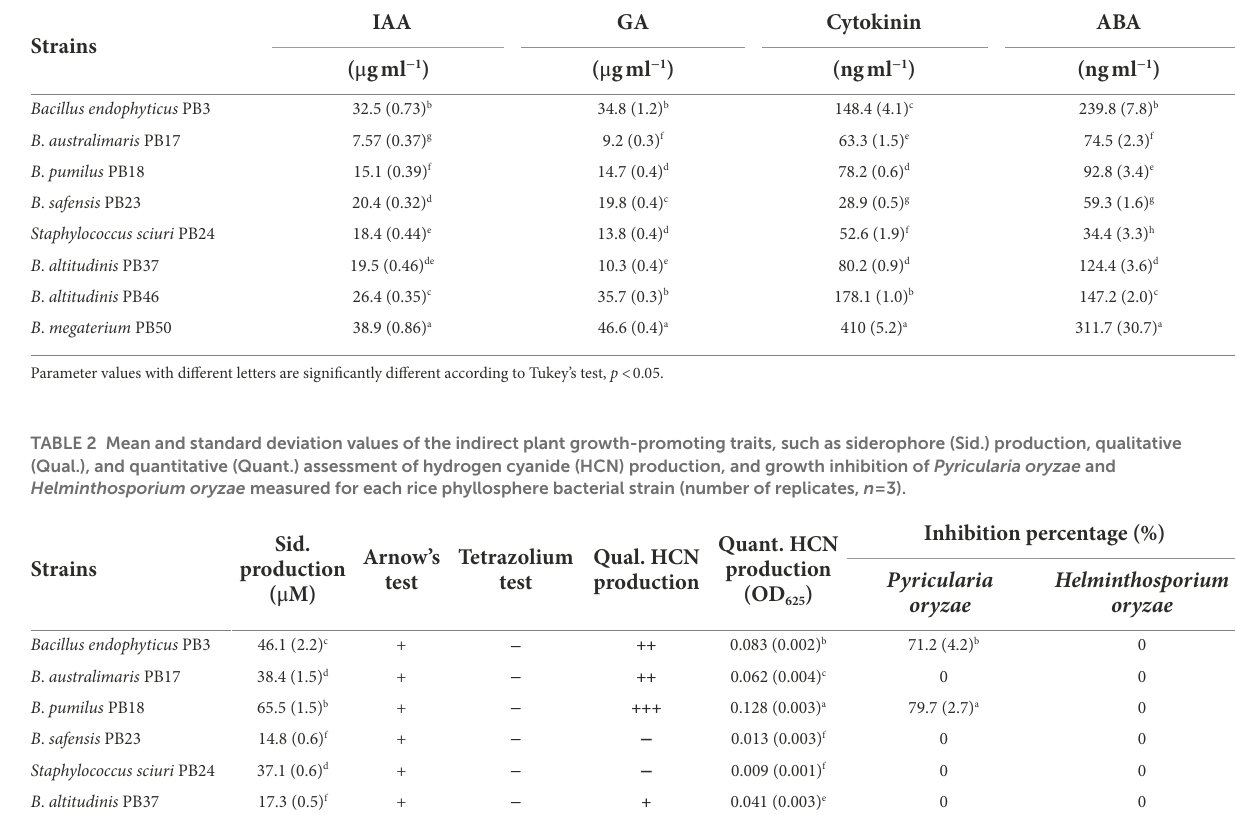
TABLE 1 Mean and standard deviation values of the direct plant growth-promoting traits [indole-acetic acid (IAA), gibberellic acid (GA), cytokinin, and abscisic acid (ABA) production] measured for each rice phyllosphere bacterial strain (number of replicates, n = 3).